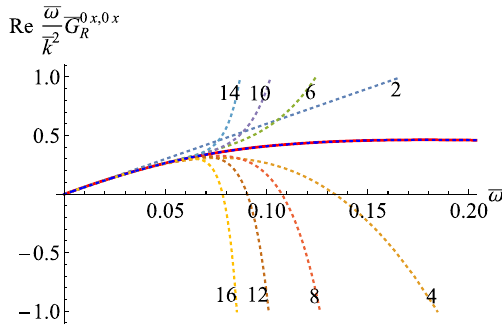
Fig. 14 The real part of the shear channel correlation function (79) (red line) compared to gradient expansions (83). The integers N on the dashed lines denote the highest power ∝ ¯ ω N included in the gradient expansion. The blue dashed line on top of the red line is the 25th order Padé approximant